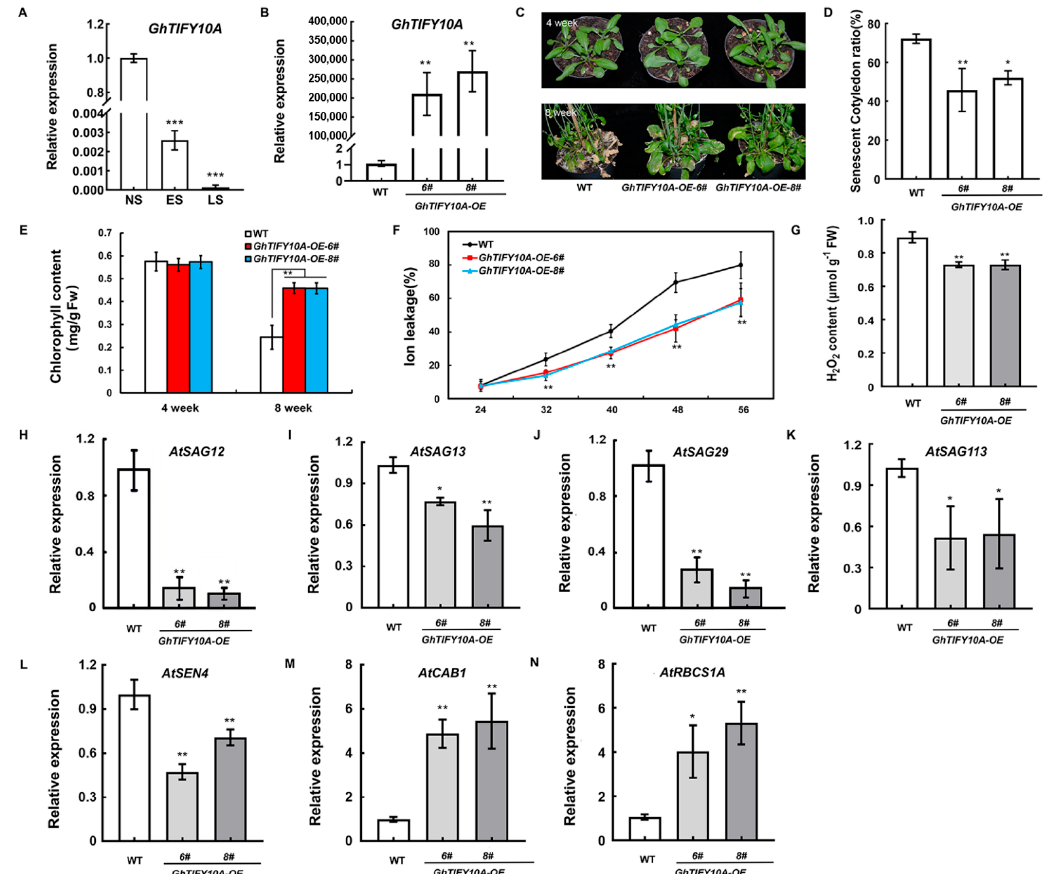
Figure 5. Overexpression of GhTIFY10A delayed leaf senescence in transgenic Arabidopsis plants. ( A ) RT-qPCR analysis of GhTIFY10A transcript levels in cotton wild-type leaves at different devel- opmental stages. Transcript levels of GhWRKY33 in NS leaves were arbitrarily set to 1. ( B ) Transcript levels of GhTIFY10A in Arabidopsis transgenic plants. ( C ) Phenotypic characteristics of WT and trans- genic plants grown for four and eight weeks, respectively. Plants were grown in a growth chamber at 22 °C under a 16 h light/8 h dark photoperiod. The natural senescence phenotype was observed from about 72 plants for each line, and representative plants were photographed. ( D ) Relative se- nescent cotyledon ratio of WT and GhTIFY10A-OE plants grown for four weeks. ( E ) Chlorophyll content in detached rosette leaves of WT and GhTIFY10A-OE plants grown for four and eight weeks, respectively. FW, fresh weight. ( F ) Membrane ion leakage of WT and GhTIFY10A -OE plants at the indicated leaf age. Leaves three to four from 12 to 15 plants of each genotype (approximately 26 leaves) were harvested and pooled. ( G ) H 2 O 2 content in rosette leaves of WT and GhTIFY10A-OE plants grown for eight weeks. ( H – N ) RT-qPCR analysis of transcript levels of senescence marker genes in leaves of WT and GhTIFY10A - OE plants in eight weeks. Data from three biological repli- cates were analyzed by ANOVA, and asterisks indicate significant differences compared with WT (* p < 0.05; ** p < 0.01; *** p < 0.001).